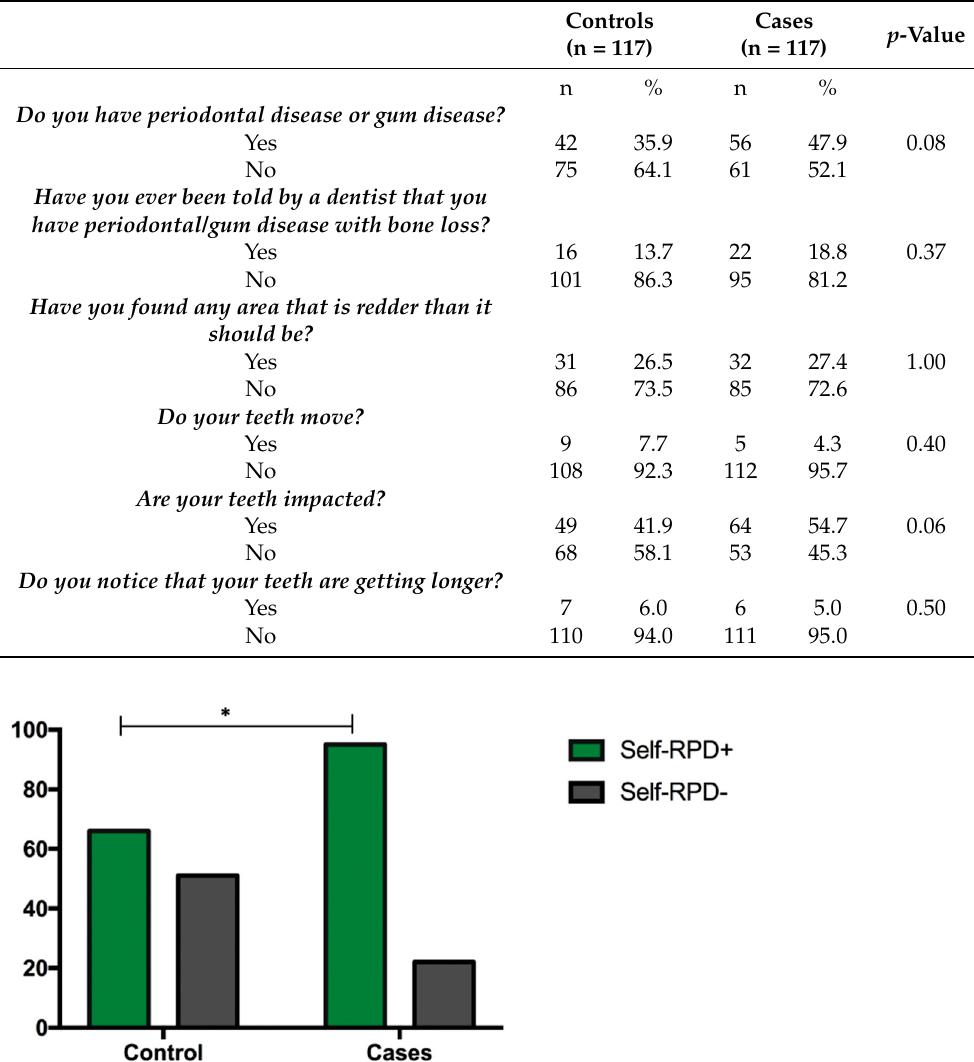
Table 2. Questions of self-reported periodontal disease differences between cases and control: descriptive data and p values.